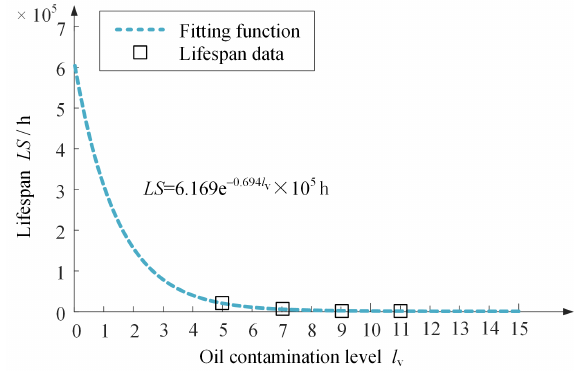
Figure 25. DJV lifespan prediction for different contamination